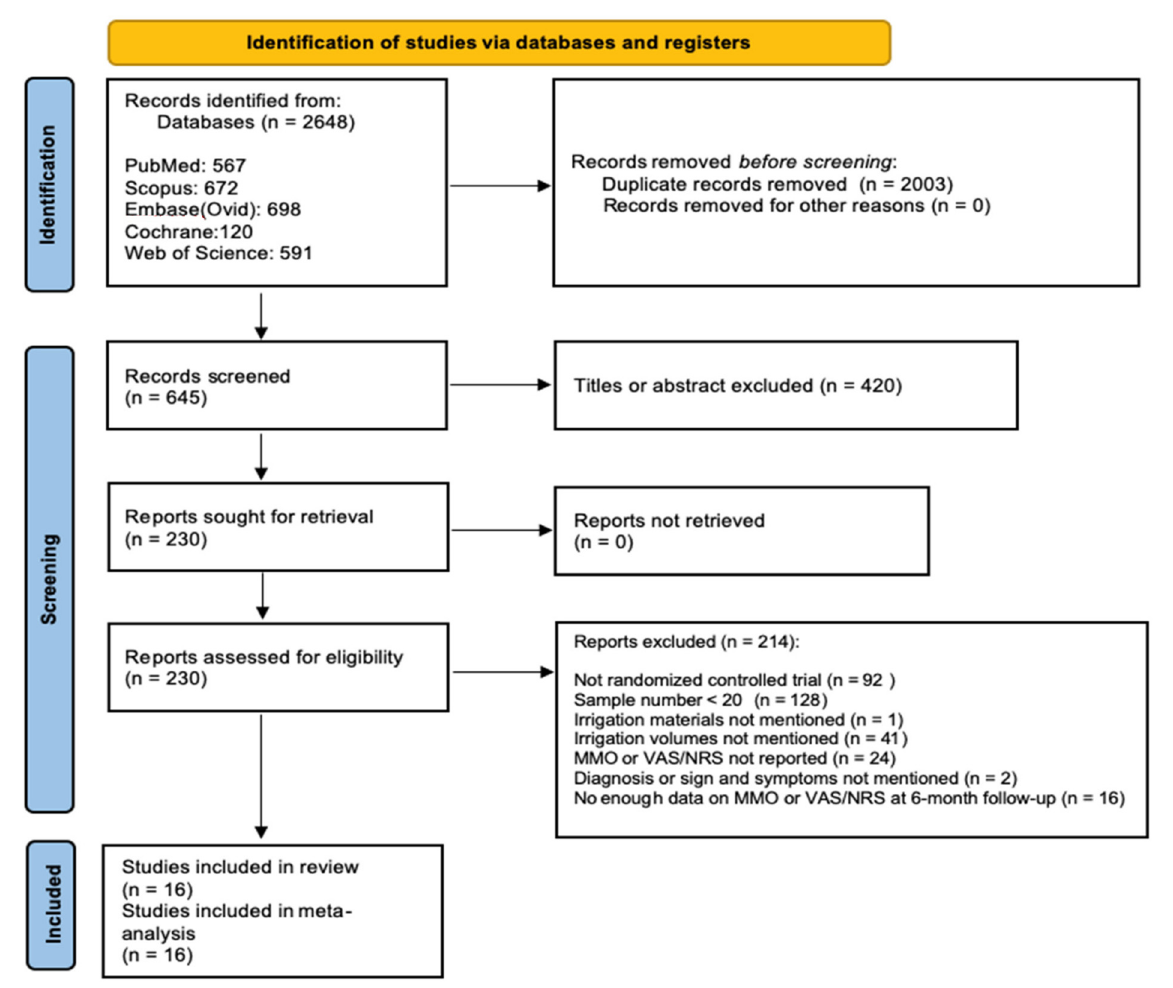
Figure 1. PRISMA 2020 flow diagram.